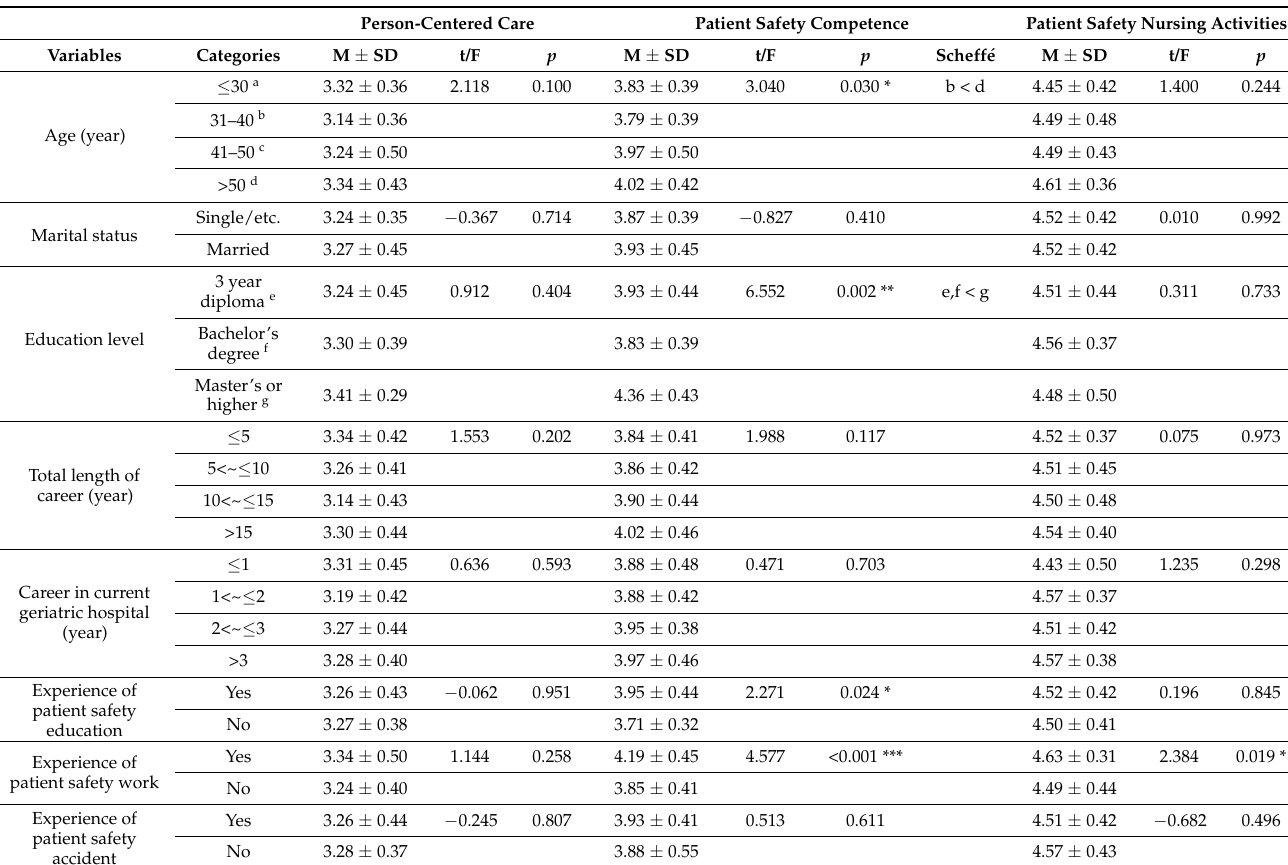
Table 3. Differences in person-centered care, patient safety competence, and patient safety nursing activities by general characteristics ( N =